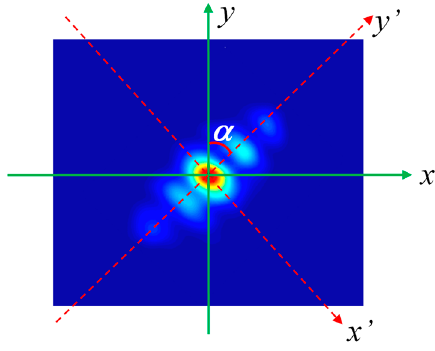
Figure 2. Asymmetric beam intensity distribution in the laboratory coordinate system.